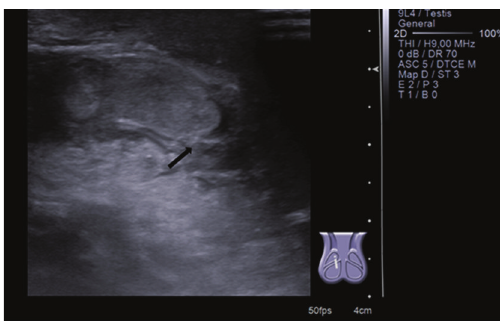
Figure 1: Scrotal ultrasound: scrotal inflammation—arrow.